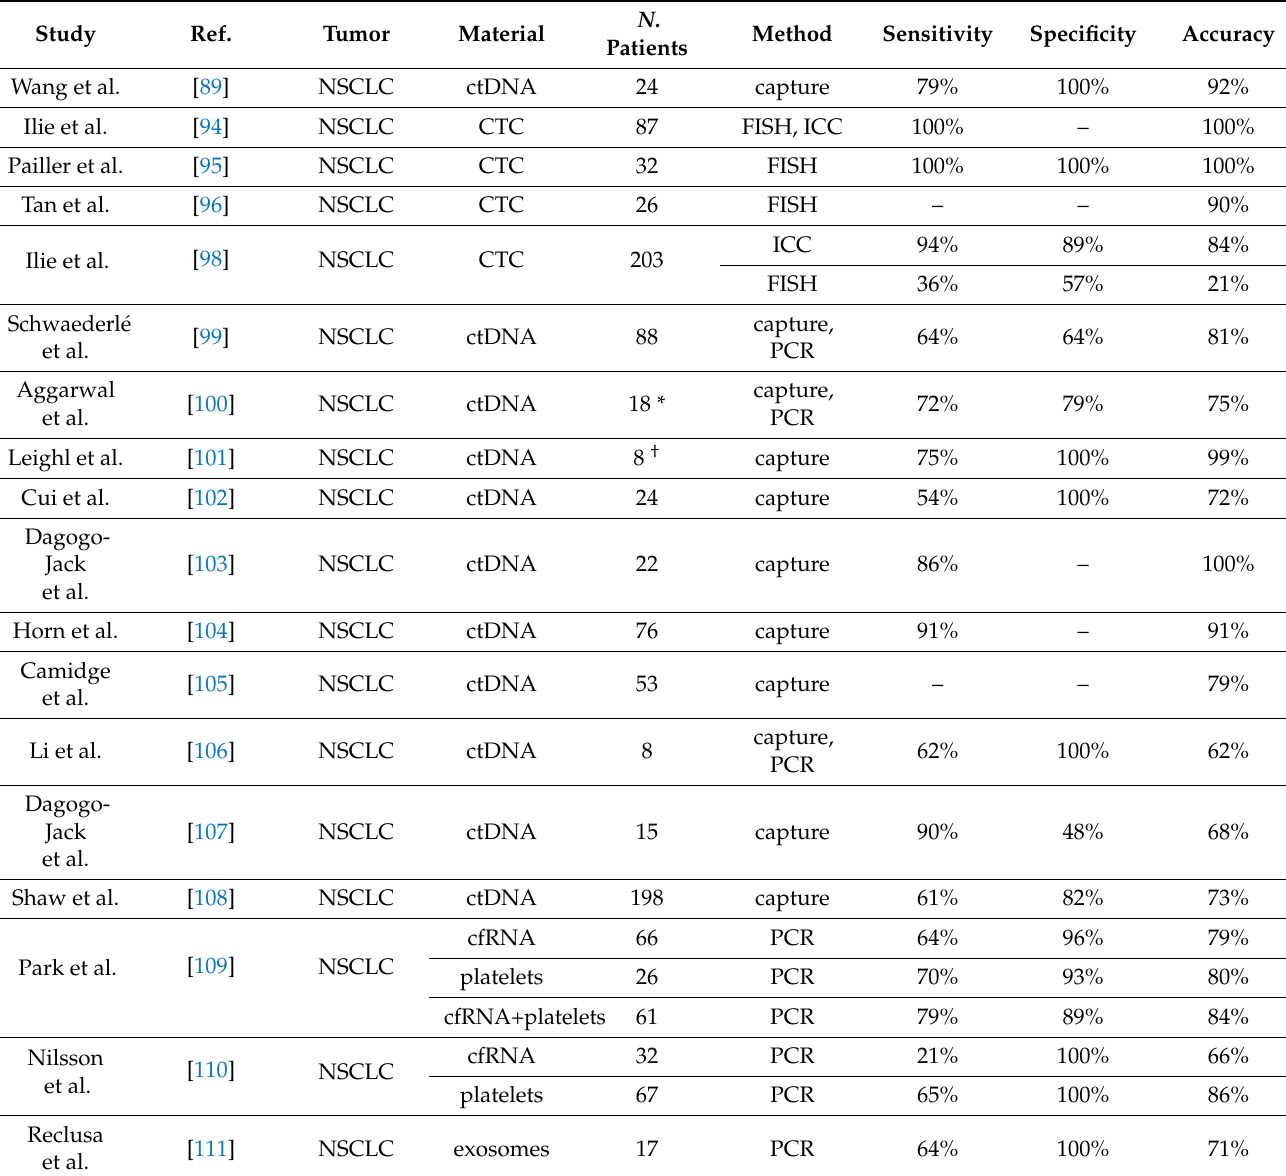
Table 1. Results obtained by liquid biopsy in a diagnostic setting, in ALK+ NSCLC patients. Tissue genotyping is used as a